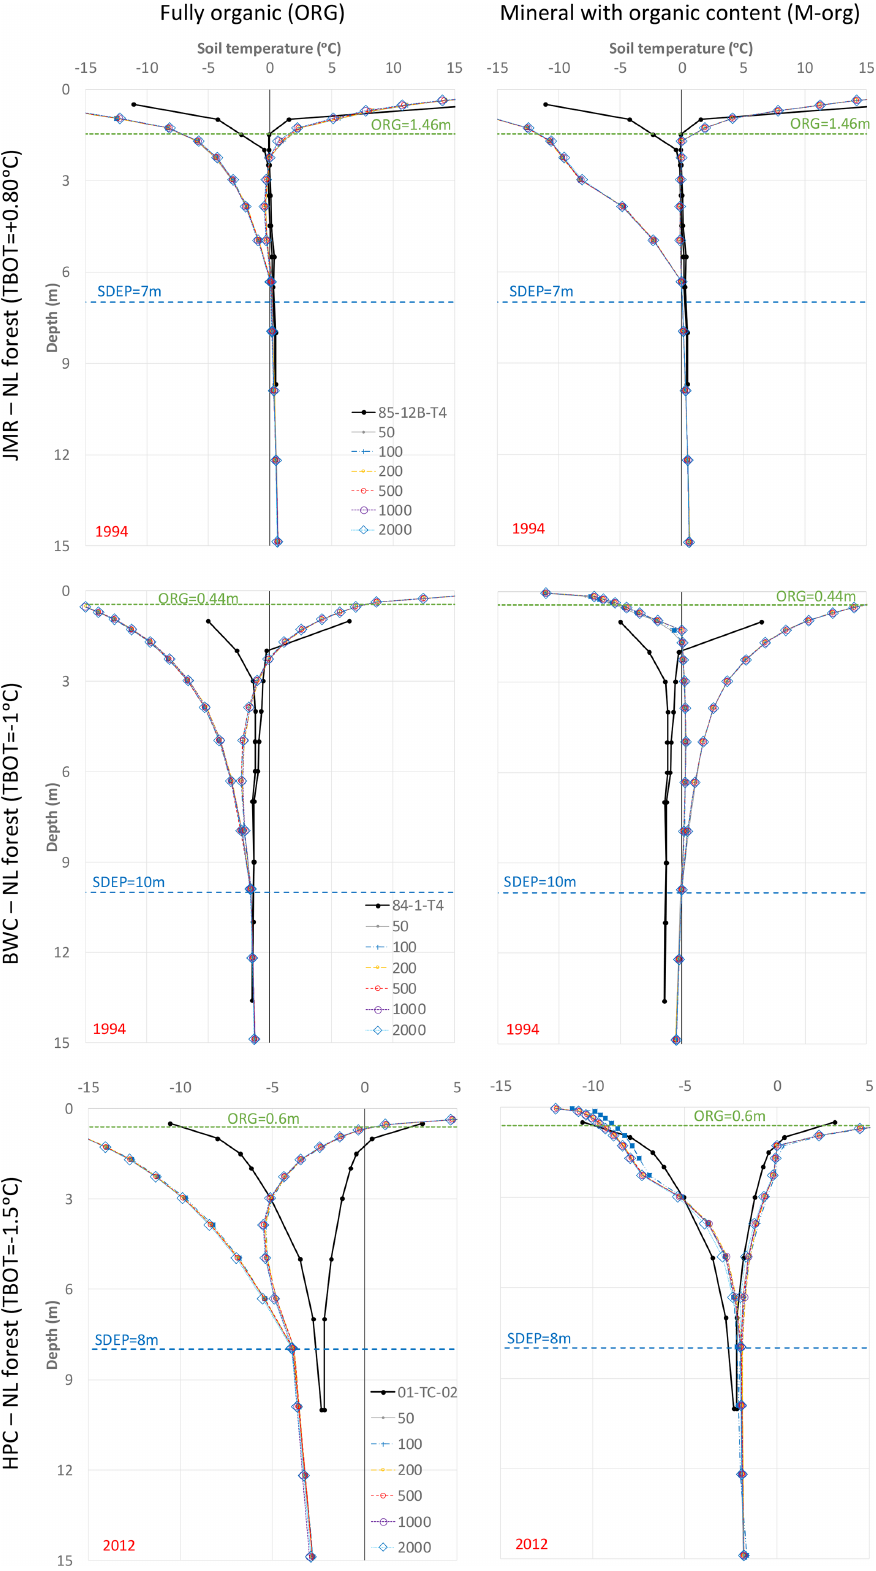
Figure 10. Impact of the number of spin-up cycles on simulated temperature envelopes for the needleleaf forest GRU for a selected year at each study site. Two organic configurations were used for each site using the SC2 layering